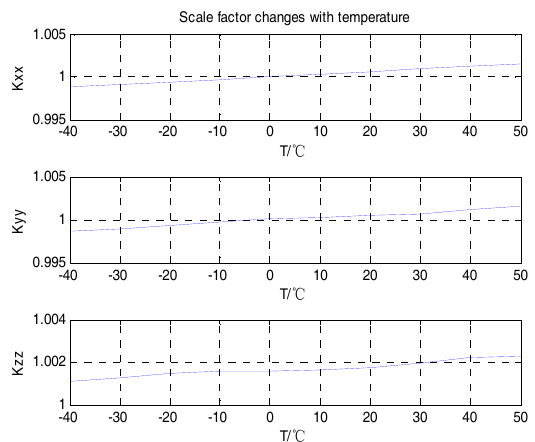
Figure 3. Block diagram of the test device.